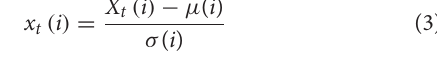
deviation of flows for each day of the year (e.g., Braga et